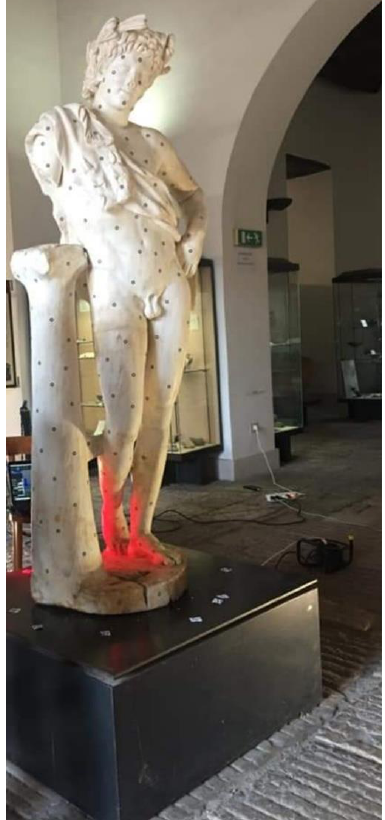
Figure 15. The preliminary phase of the scanning process.